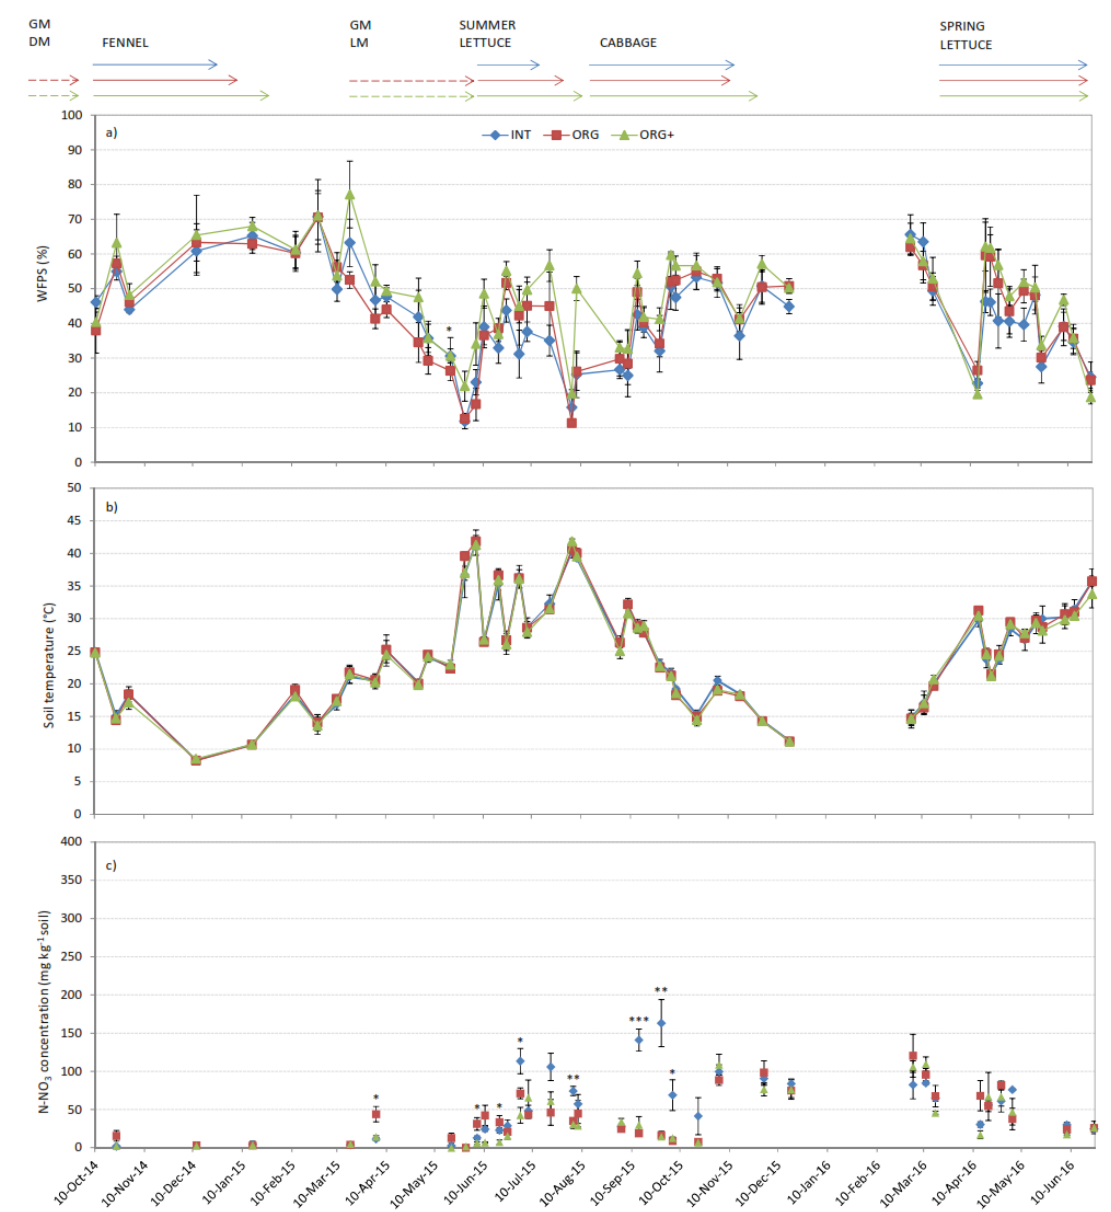
Figure 3. Data recorded in F1: ( a ) Soil water filled pore space (WFPS); ( b ) soil temperature; ( c ) soil nitrate (N – NO 3 ) concentration for each treatment. Simple arrows indicate fertilization events, and dashed arrows the primary tillage of each crop. On field 1 (F1) the temporal crop sequence was: